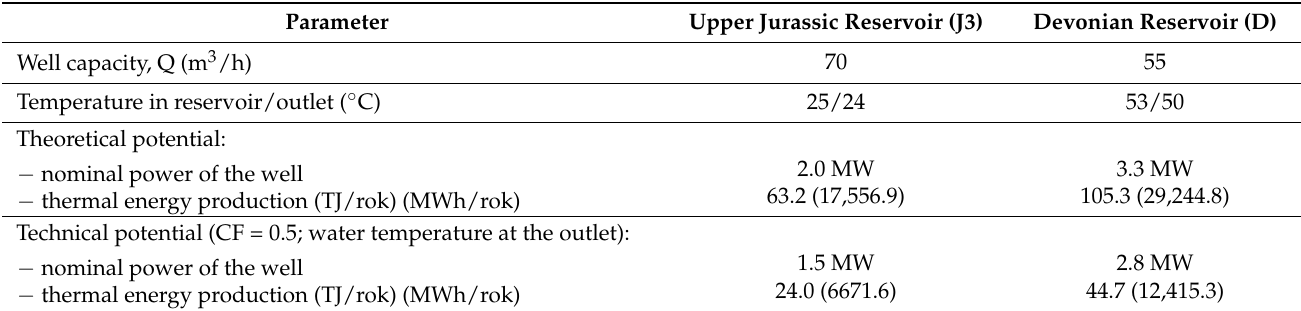
Table 4. Predicted heat potential of thermal waters of the Krakow GT-1